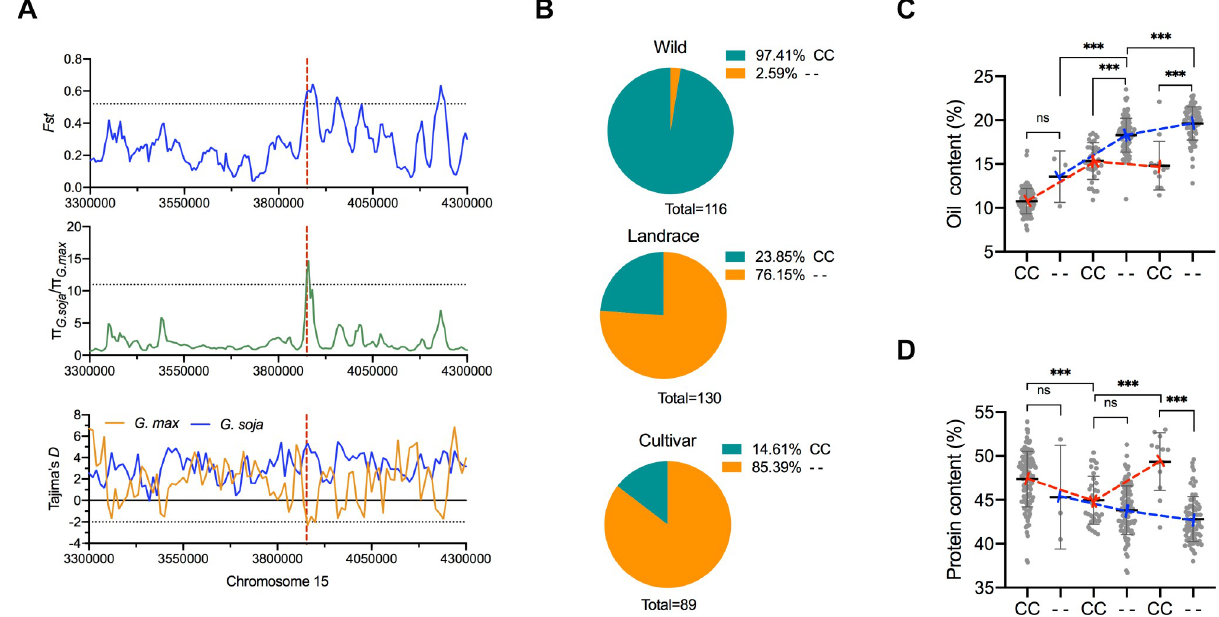
Fig 3. Genetic diversity and allele analysis of GmSWEET39 . ( A ) Genetic diversity ( π ), Tajima’s D , and fixation index ( Fst ) among the three groups across the 1-Mb genomic region harboring GmSWEET39 . The horizontal dotted line indicates the genome-wide threshold as described by Wang et al [50]. A red dashed line indicates the physical position of GmSWEET39 . ( B ) Genotype frequency distribution of CC presence (CC) and absence (- -) in GmSWEET39 in wild, landrace, and improved cultivar. Allelic analysis of CC presence (CC) and absence (- -) in GmSWEET39 on oil (C) and protein content ( D ). ��� indicates the statistical significance at p < 0.001. ns: not significant.